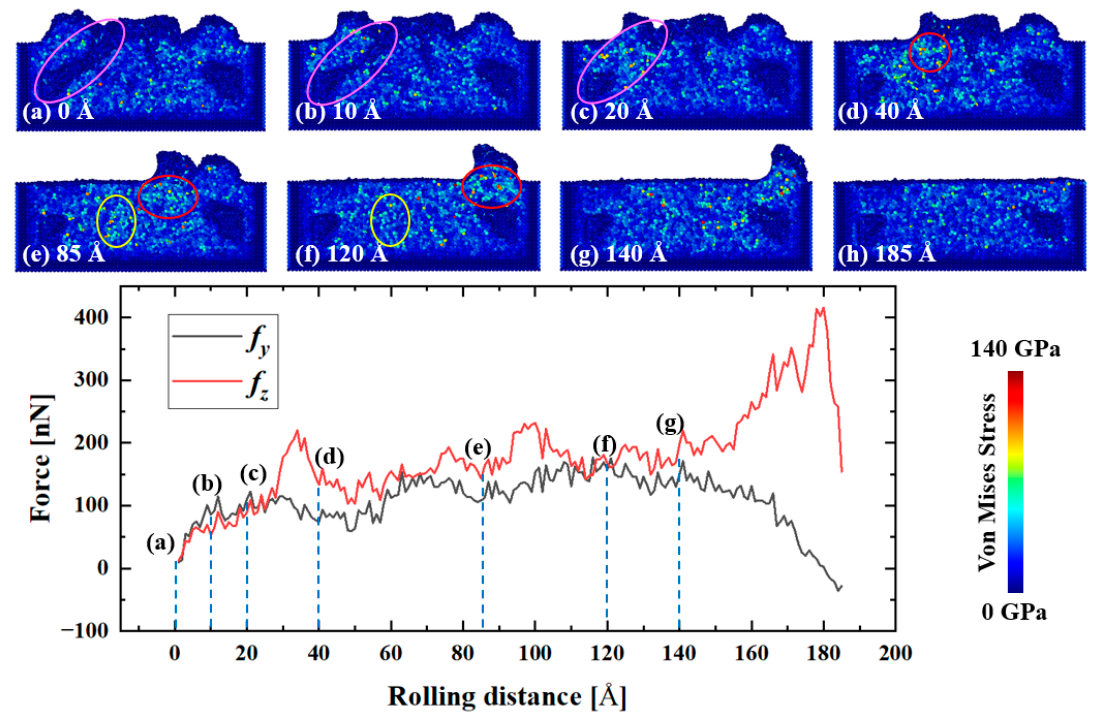
Figure 7. Microstructural evolution and the force variation with rolling distance during the rolling process, where ( a – h ) represent the cross-section view of the MD model at different rolling distances. fy and fz represent the frictional and the normal force. The pink, red, and yellow circles track the internal stress evolution in these regions during the rolling